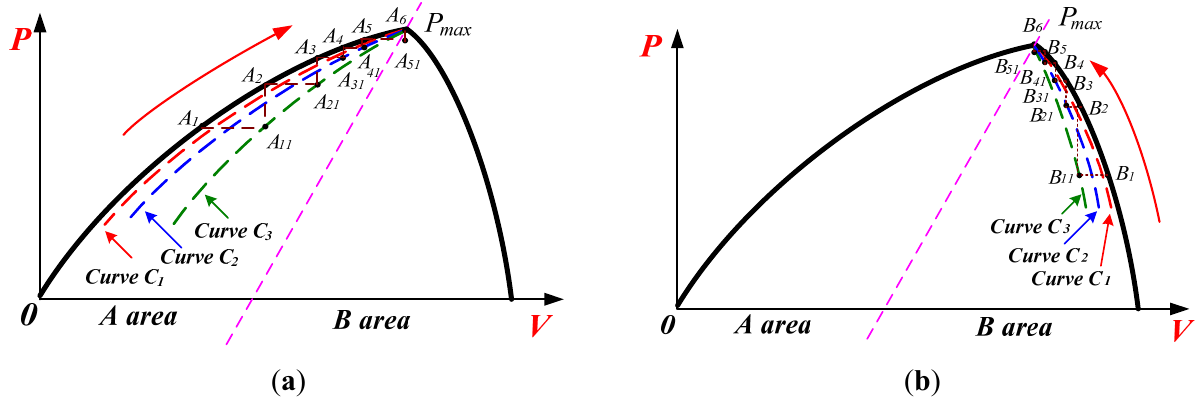
Figure 9. PV output power curves with respect to the PV output voltage: ( a ) operated in A area; ( b ) operated in B area.